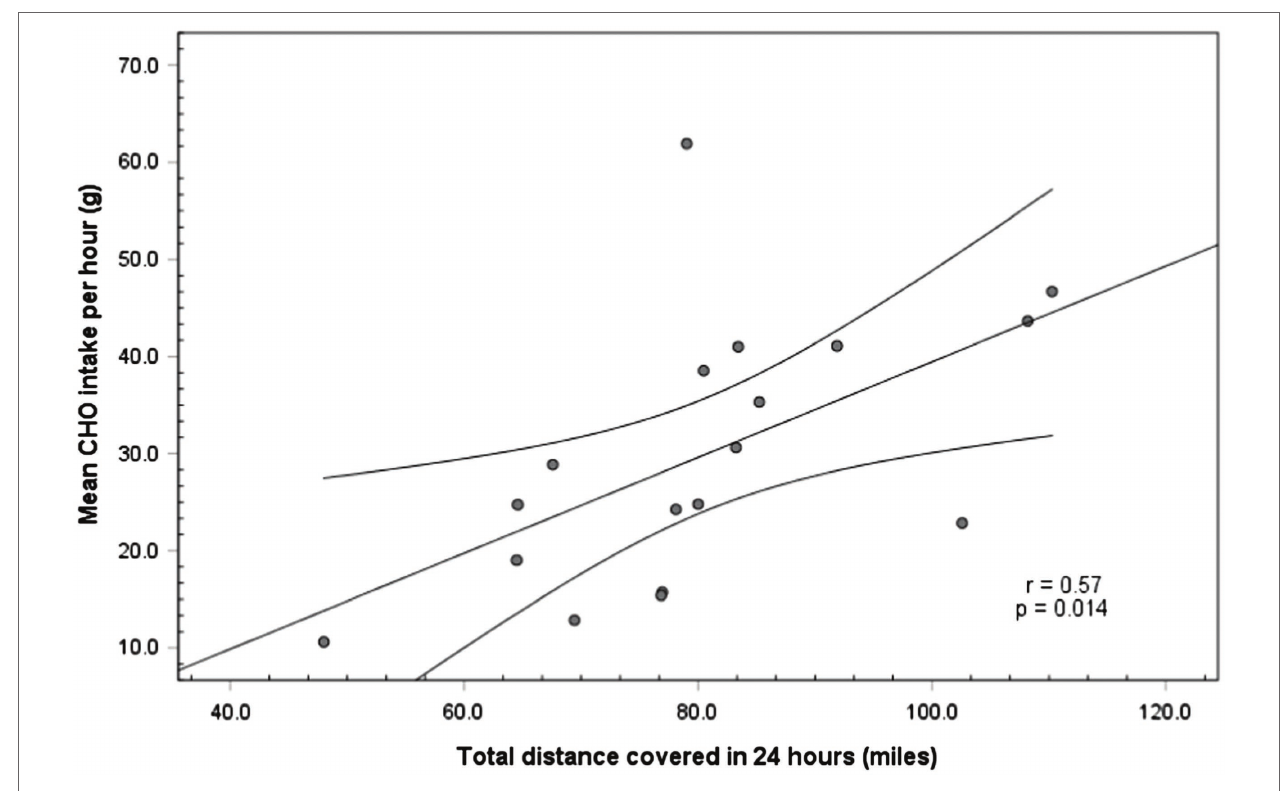
FIGURE 3 | Total race distance covered vs. CHO intake (g·h -1 ) during 24 h races for G24 runners showing a moderate positive